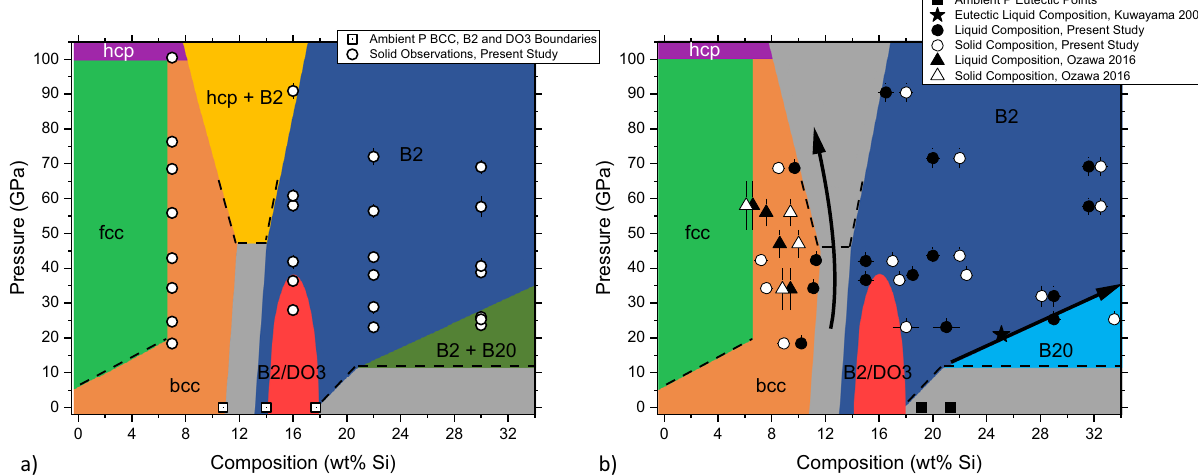
Fig. 3 Solidus and liquidus projections for the Fe – Si system at high pressures. a Pressure – composition (P-X) phase diagram showing subsolidus phase relations just below melting. Open circles indicate the P-X conditions of solid measurement, and open squares indicate ambient pressure solubility limits of the bcc, B2, and DO3 phases 30 . b Pressure – composition phase diagram showing the liquidus phases and eutectic points of the Fe – Si system. Open and closed circles indicate solid and liquid compositions of recovered samples from the present study, respectively. Open and closed triangles indicate solid and liquid compositions reported in Ozawa et al. 29 . Squares and the star indicate eutectic points from literature 22,30 . Error bars for both fi gures represent one standard deviation for pressure and composition. For further details see